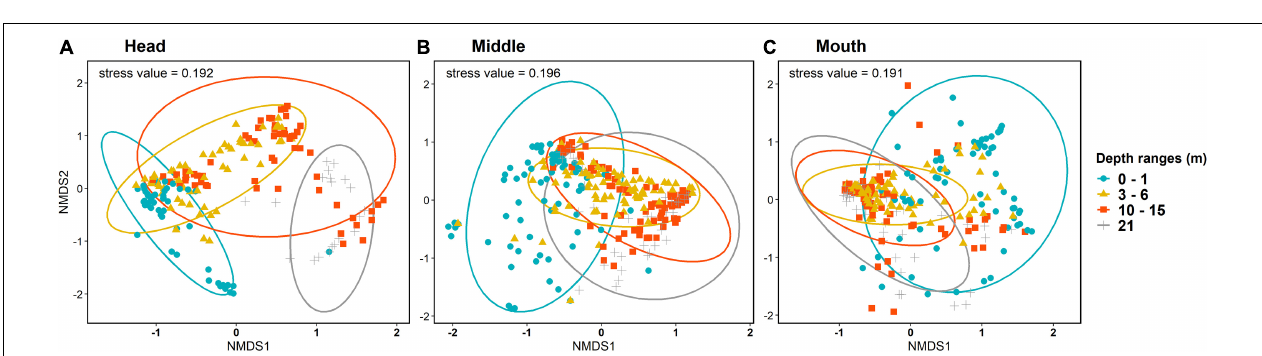
FIGURE 4 | Estimated smooth interactive effect of depth and salinity on diversity measures (species richness, Shannon diversity, and Pielou evenness’s) as a function of the generalized additive mixed model (GAMM) output. (A–C) Estimated interactive effect of depth and salinity on species richness. (D–F) Estimated interactive effect of depth and salinity on Shannon diversity. (G–I) Estimated interactive effect of depth and salinity on Pielou evenness. The gray zones represent absent depth-by-salinity combinations.